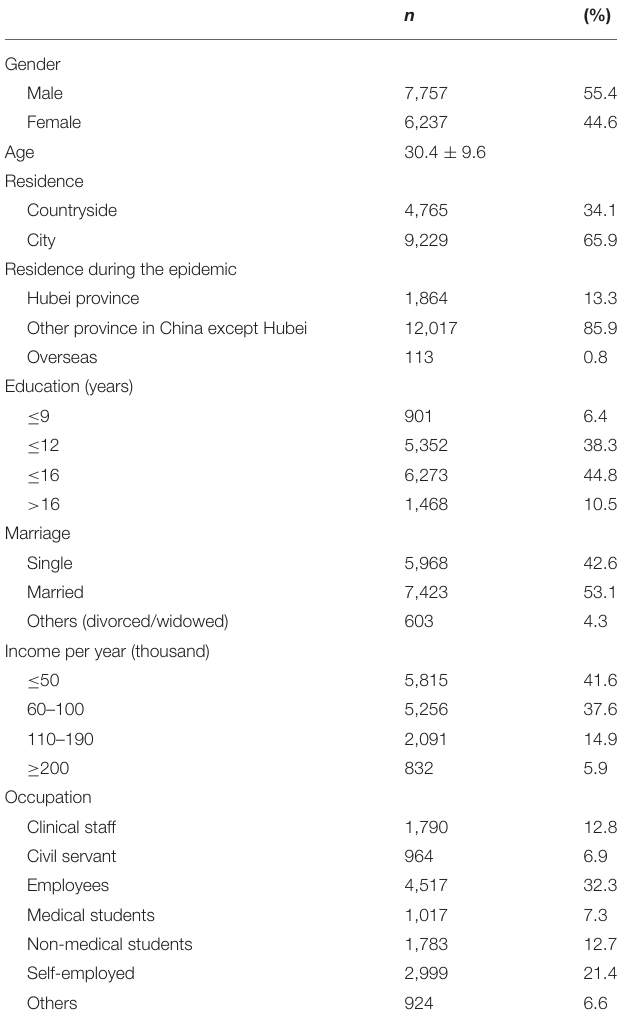
TABLE 1 | Demographic characteristics of participants ( N =